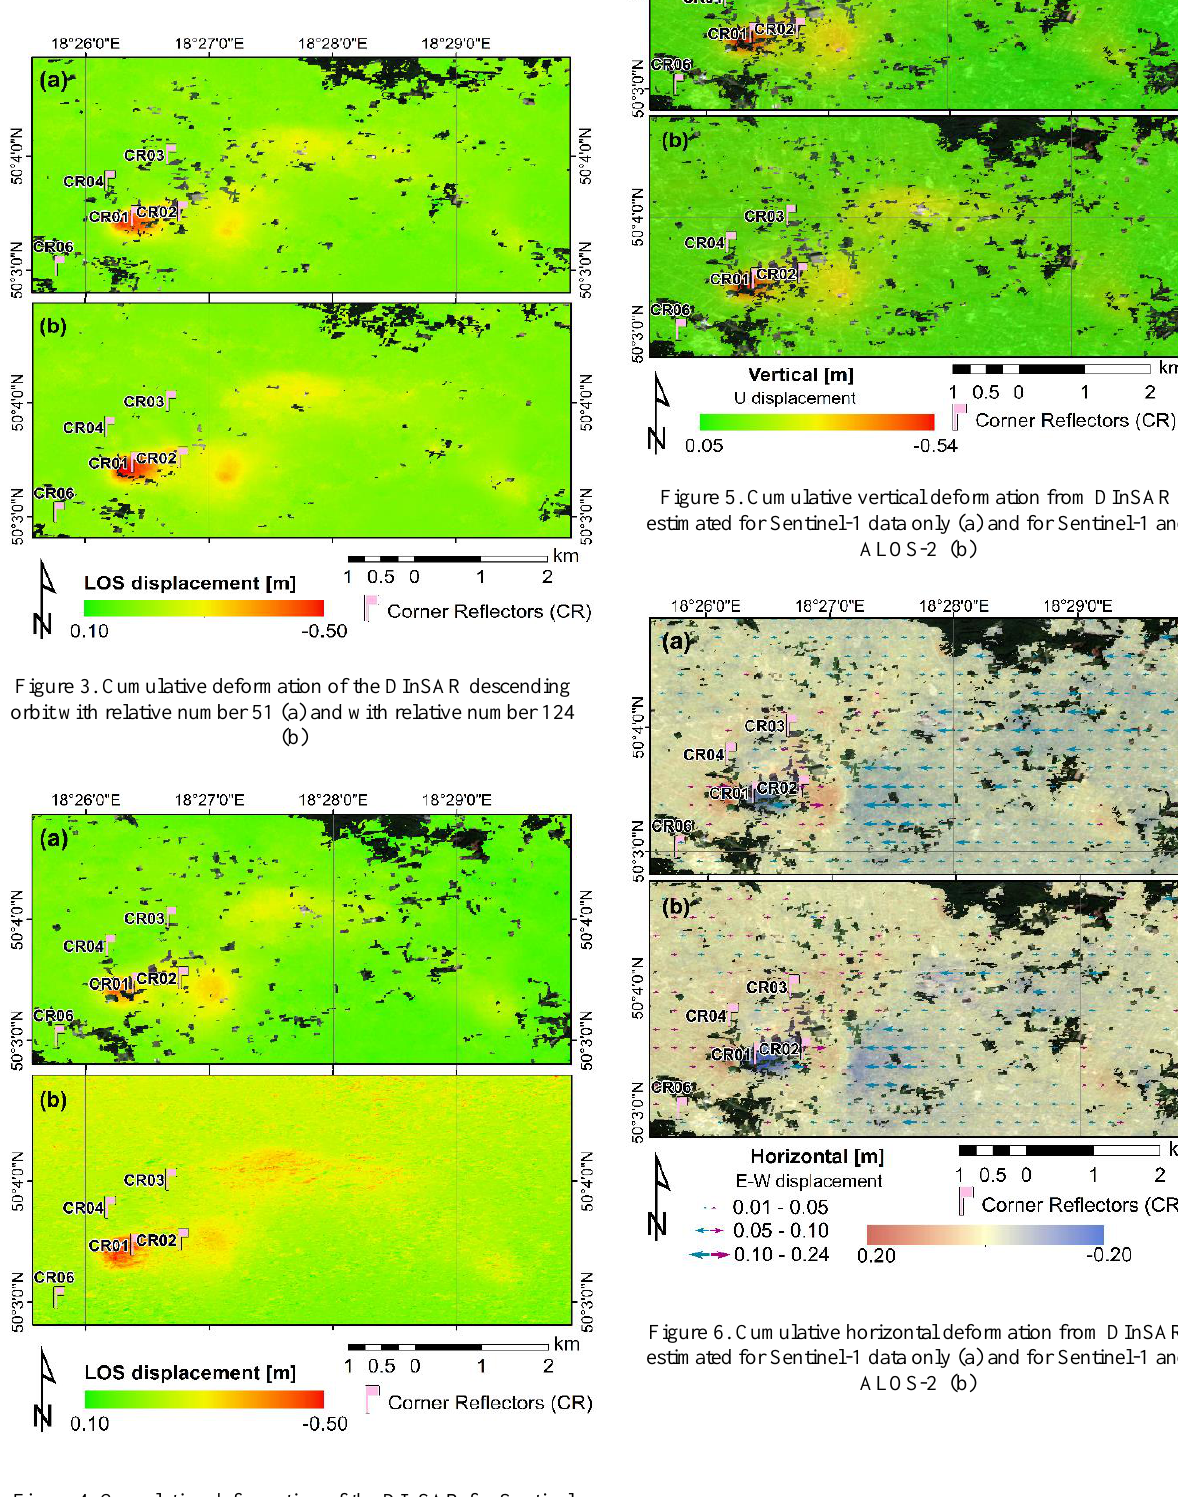
Figure 4. Cumulative deformation of the DInSAR for Sentinel 1A/B ascending orbit with relative number 175 (a) and for ALOS-2 ascending data (b)